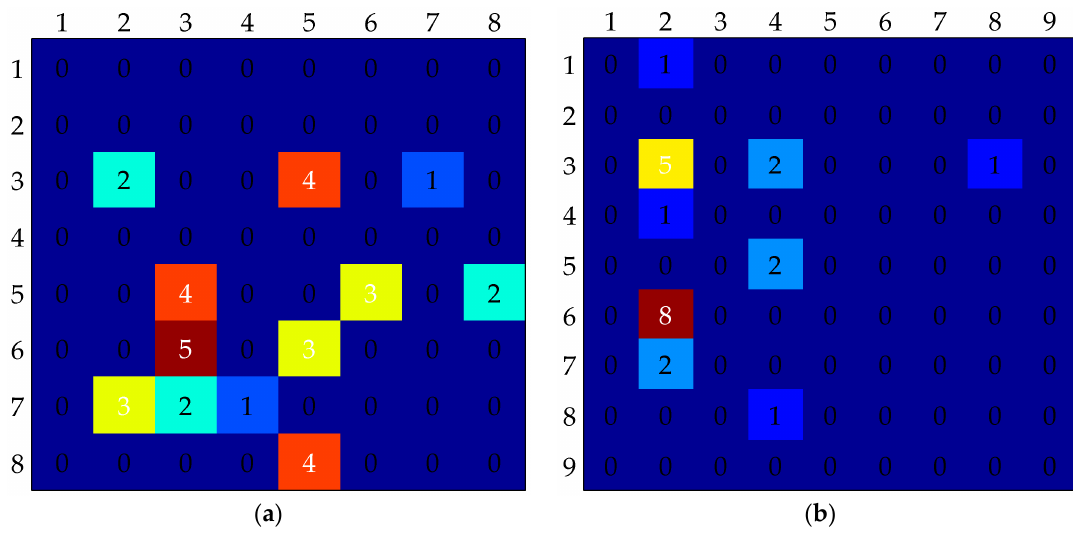
Figure 8. Confusion matrix of devel 03 and devel 19. ( a ) Confusion matrix of devel 03; ( b ) Confusion matrix of devel 19.